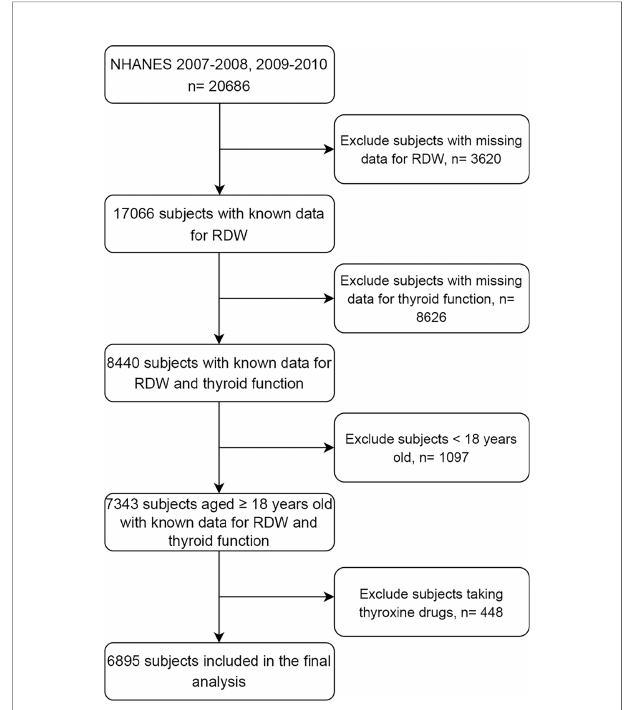
FIGURE 1 | Study fl owchart. NHANES, National Health and Nutrition Examination Survey; RDW, red blood cell distribution